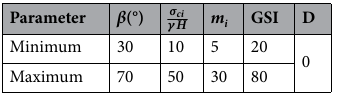
Table 2. Range of slope parameters in this